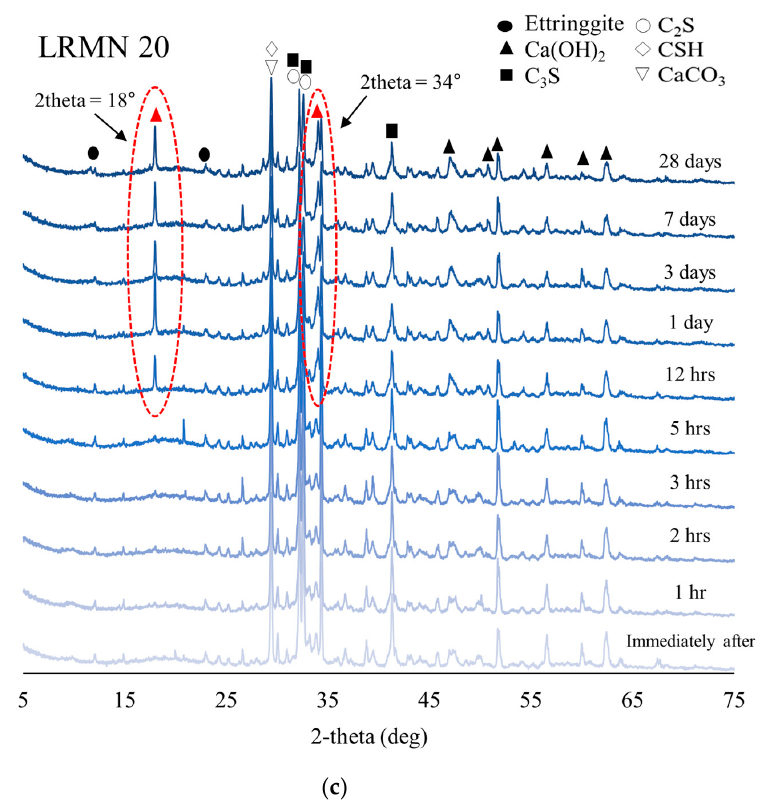
Figure 8. XRD spectra of ( a ) Plain, ( b ) LRM 20, and ( c ) LRMN 20.